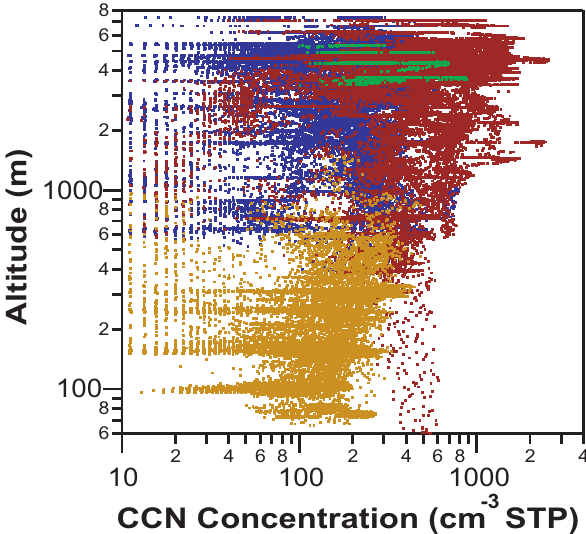
Fig. 4. Vertical profiles of fine particle (CN) concentrations measured during ARCPAC. Data shown are 1 Hz measurements and are color-coded by air mass type as in Figures 1 and 2.